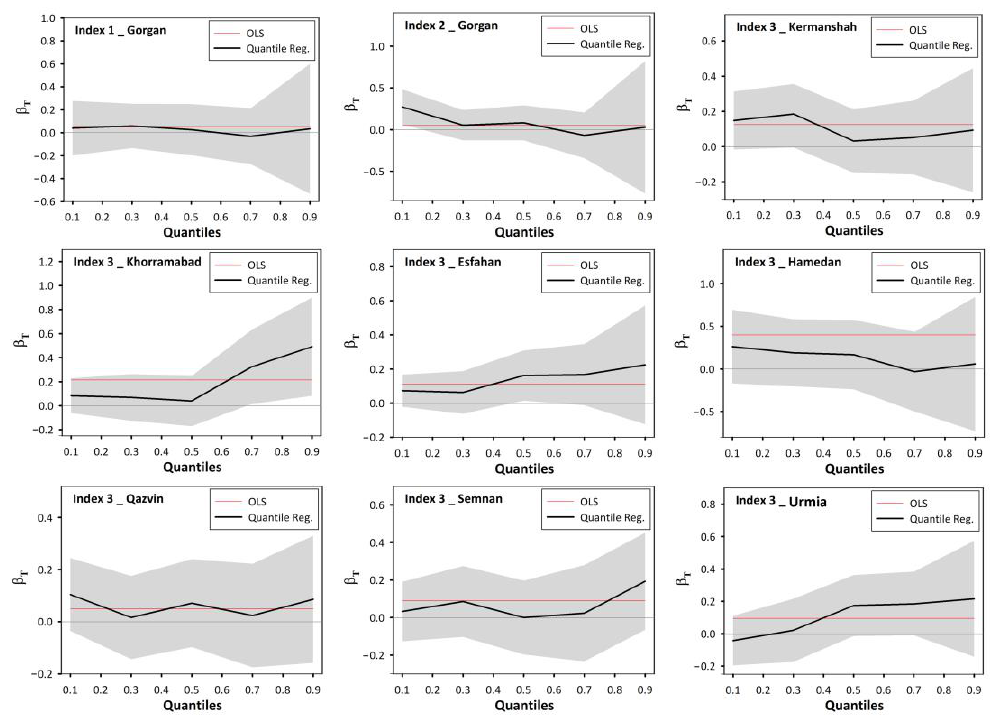
Figure 5. The quantile regression coefficients for extreme rainfall indices.